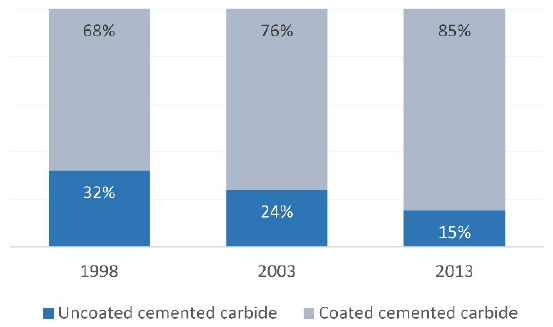
Figure 6. World market of cemented carbide cutting tools. Data from Dedalus Consulting, taken from [7].